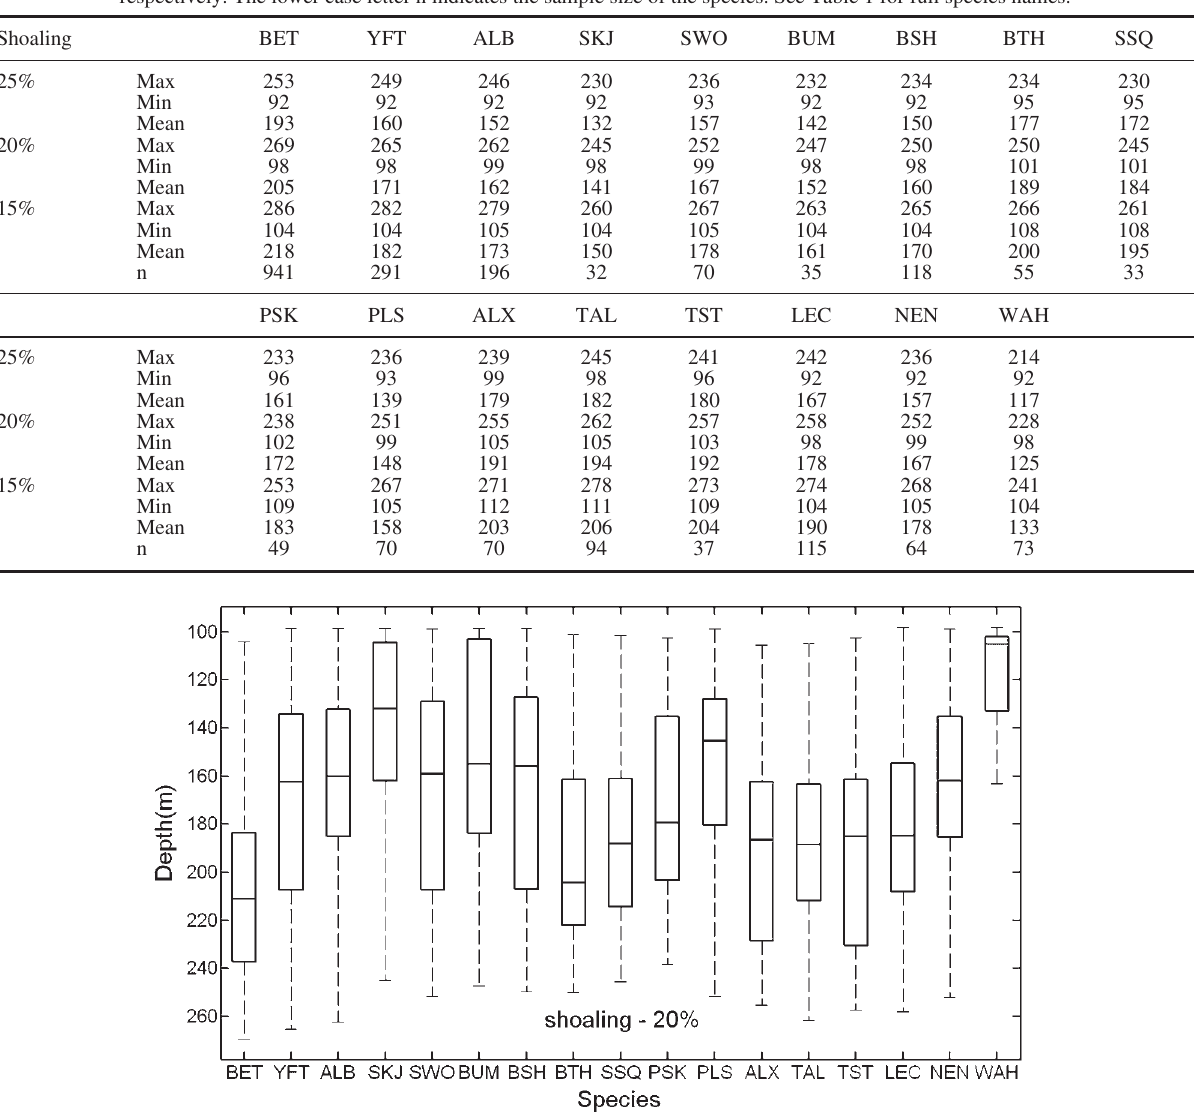
Table 2. – Estimated depth ranges (m) under constant shoaling assumptions for 17 pelagic species captured in the longline observer trip in the central-eastern Pacific Ocean in February-November 2006. The Max, Min and Mean represented maximum, minimum and mean depth, respectively. The lower case letter n indicates the sample size of the species. See Table 1 for full species names. Shoaling